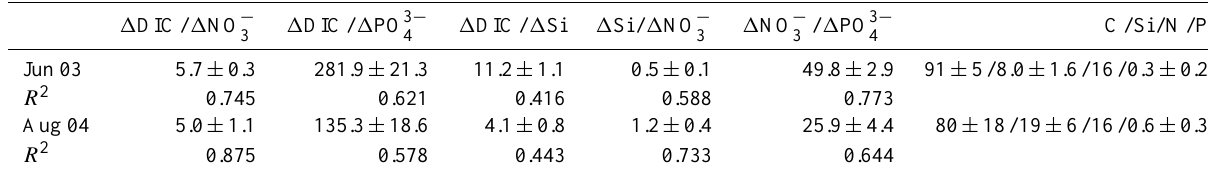
Fig. 4. Relationships between DIC and nutrients, between 1 DIC and 1 nutrients, and their sampling geographic locations for June 2003. Panels (a) to (d) show relationships of DIC to alkalinity, NO − , PO 3 − , and Si(OH) 4 , respectively, with conservative mixing lines (black 3 4 dashed lines) and Redfield-type biological removal lines (green dashed lines). “ X ” markers with abbreviations “M”, “A”, and “S” are the same end-members as in Fig. 3. For salinity higher than 24, Low Silicate and Low Nitrogen (LSiLN) data were on the southwestern Louisiana Bight, and for salinity less than 24 data (“S < 24”), High Silicate and Low Nitrogen (HSiLN) data were on the northeastern Louisiana Bight (e) . Panels (f) to (h) show relationships of 1 DIC to 1 NO − , 1 PO 3 − , and 1 Si, respectively, with their correlation lines (dashed lines). All 3 4 panels share the same legends as in (a, f) . Table 2. Stoichiometry of DIC uptake and nutrient removals and their correlation coefficients ( R 2